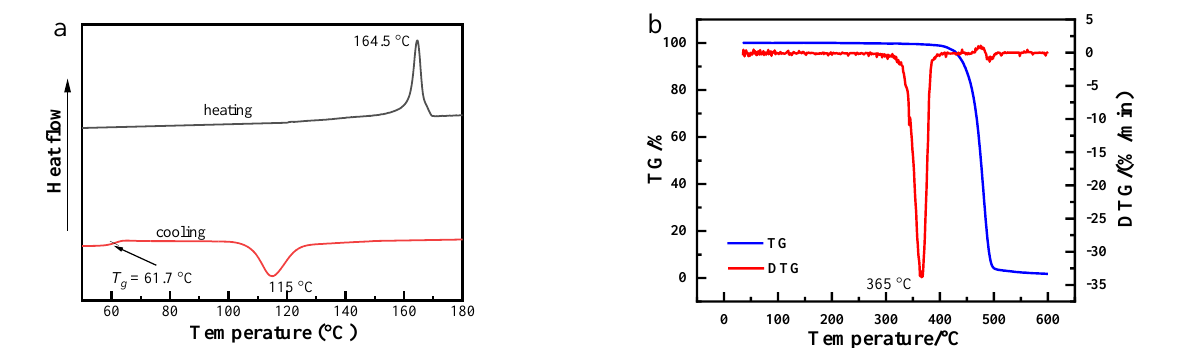
Figure 2. ( a ): DSC cooling and heating curves of PLLA at 10 °C/min; ( b ): the TGA and DTG curves of PLLA.